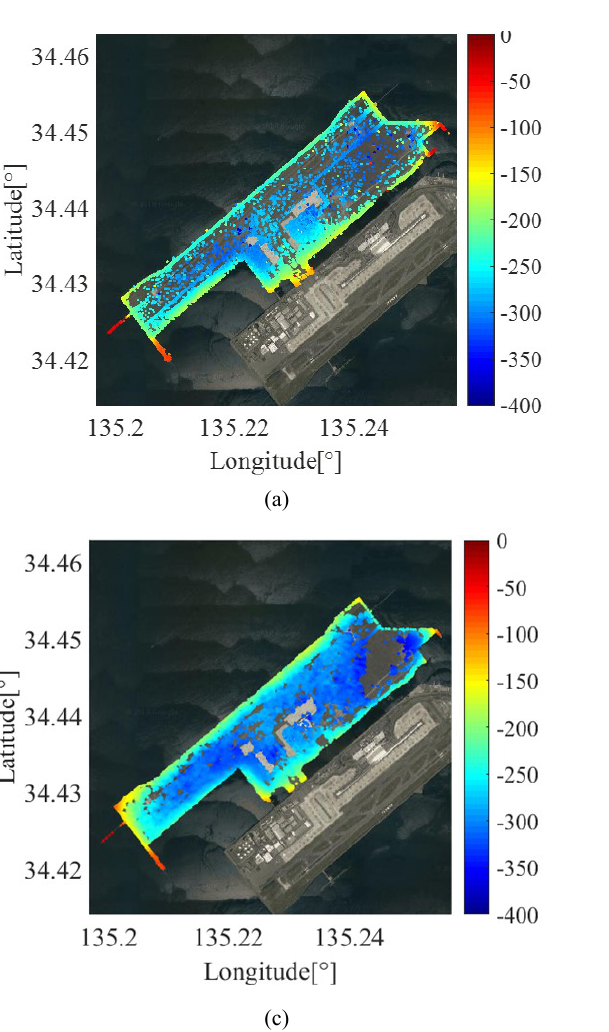
Figure 4. Locations of geodetic data used for (a) interpolation and (b) validation. The red and green points represent leveling and GPS locations, respectively. Map data ©2018 Google,